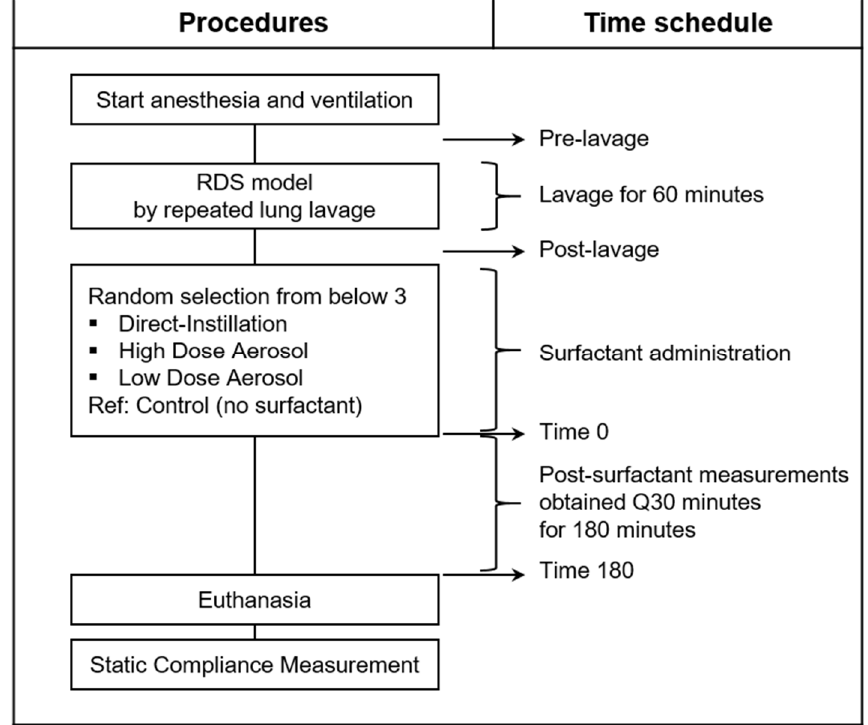
Figure 1. Time schedule for animal experimental procedures. The sequence of procedures for lung lavage to establish surfactant-deficiency and lung injury, randomized groups, and time schedule for measurements. The post-lavage condition shows animals following lung injury and stabilization and represents the baseline pre-treatment condition and the time at which treatment was instituted. Time point 0 represents timepoint following completion of surfactant administration. The time increments represent values obtained 30 min after completion of treatment and at 30 min intervals thereafter.